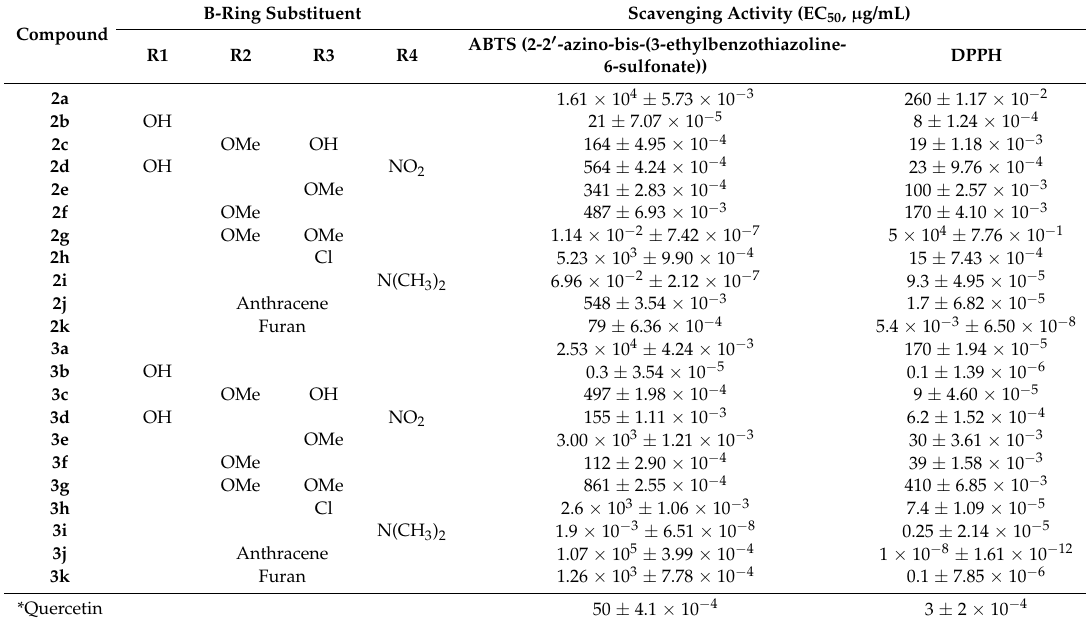
Table 1. Antioxidant activity of synthesized compounds 2a – 2k and 3a – 3k .